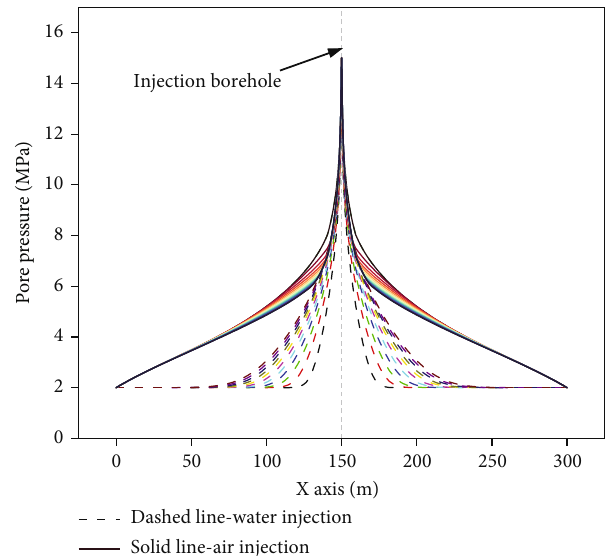
Figure 9: Pore pressures under water injection and air injection for 12 hours, respectively, along line L (Orange dashed line shown in Figure 1). Data is recorded and plotted every 2 hours.